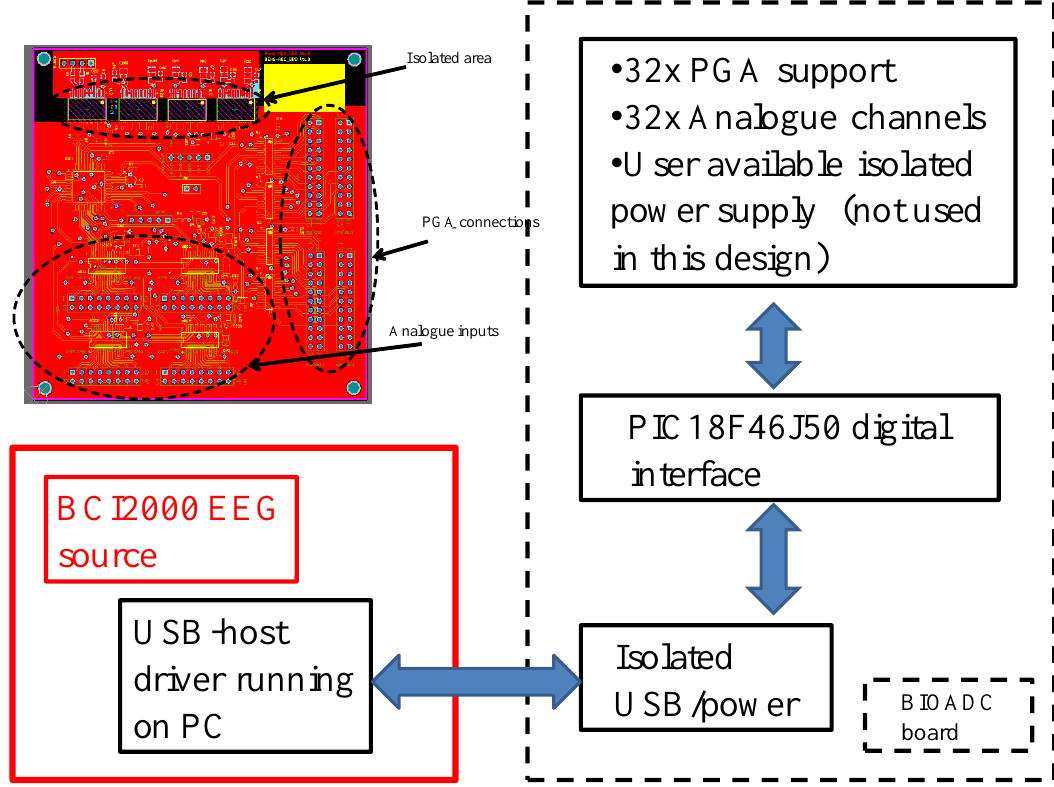
Figure 4. BIOADC main board and block diagram (adapted from [52]). EEG, electroencephalography; CS, chip-select lines; ADC, analogue to digital converter; PGA, programmable gain amplifier.